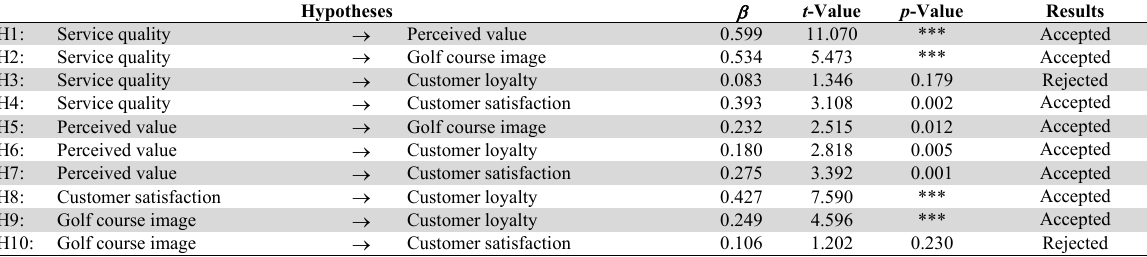
Results and hypotheses